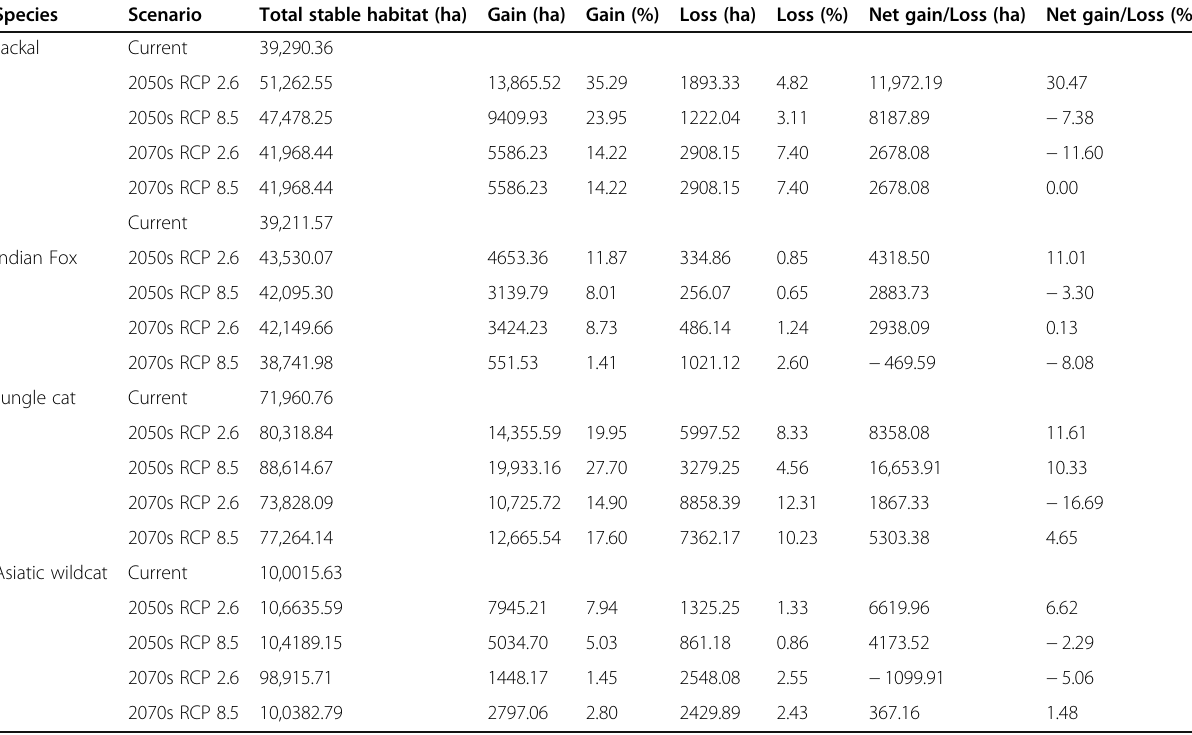
malized Difference Vegetation Index in summer season Table 2 Change in the predicted distribution of golden jackal, Indian fox, jungle cat, and Asiatic wildcat in and around Bandhavgarh Tiger Reserve, Madhya Pradesh, India under low (RCP 2.6) and high (RCP 8.5) representative concentration pathway scenarios for the years 2050s and 2070s using the model developed by Model for Inter-disciplinary Research on Climate change (MIROC5) Species